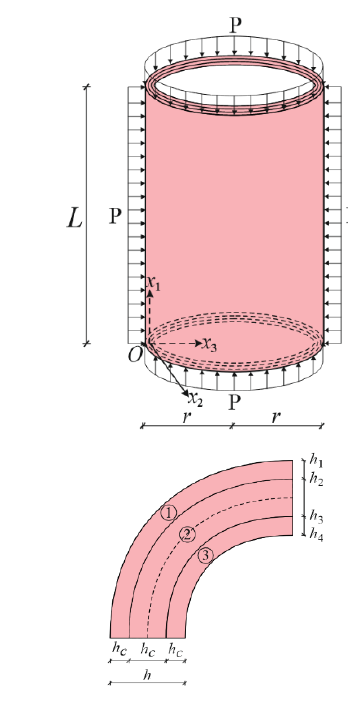
Figure 4. ( a ) M/C/M and ( b ) C/M/C cylindrical shells under hydrostatic pressure and their cross sections.